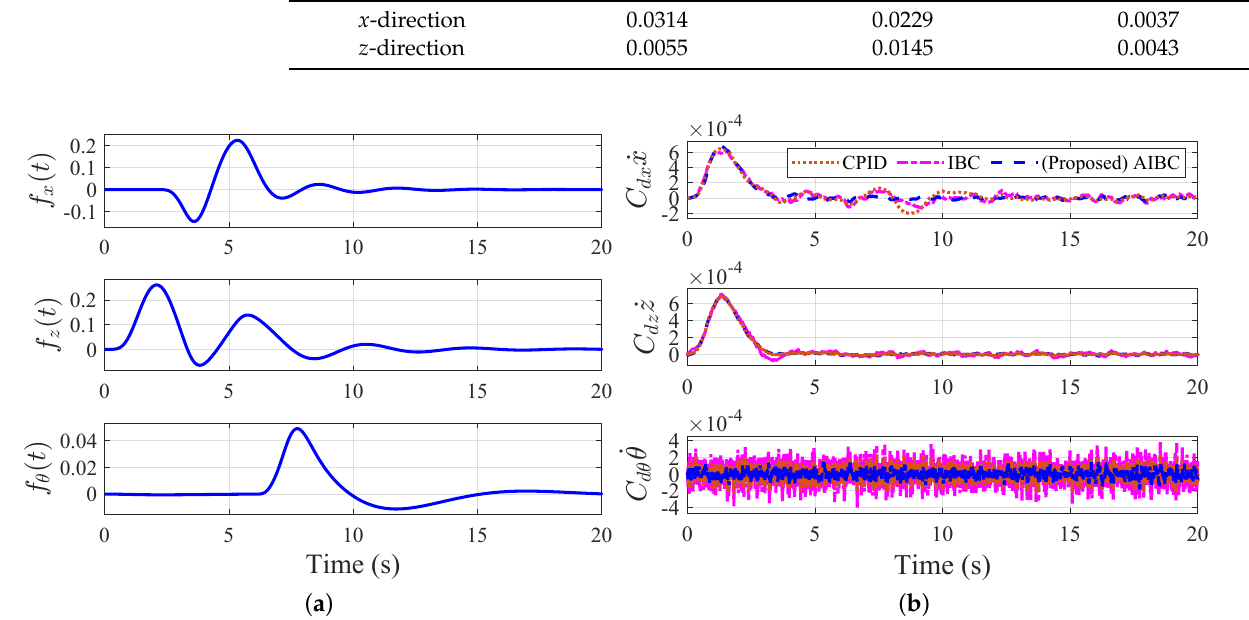
Figure 3. Evolution of external disturbances. ( a ) the time-varying disturbances; ( b ) the state- dependent viscous